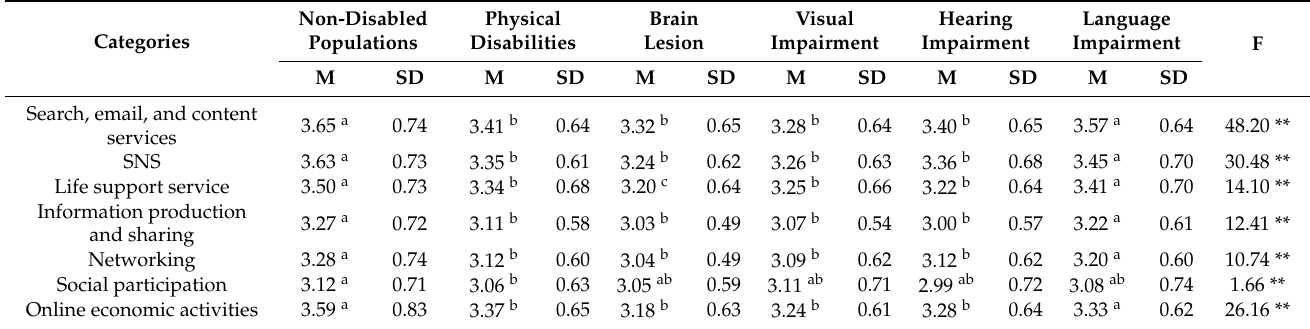
Table 3. COVID-19 effect on Internet service usage changes.